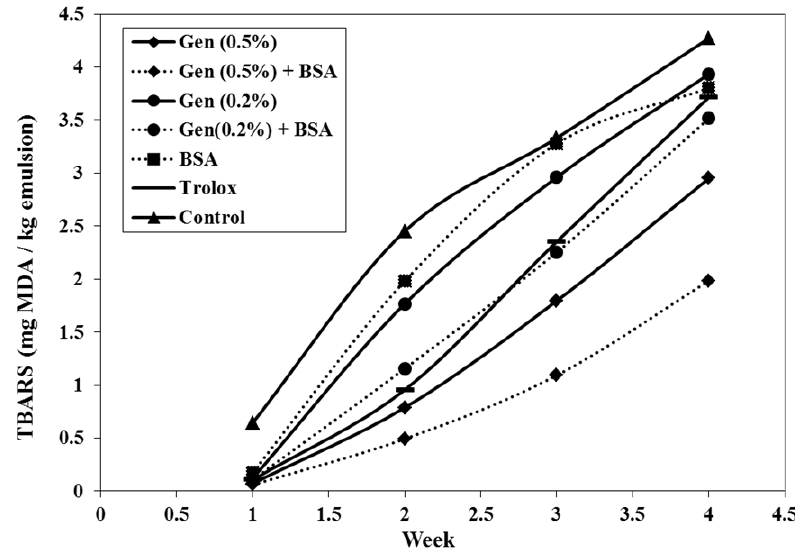
Figure 3. Change of Thiobarbituric Acid Reactive Substances (TBARS) over time, stored at 37 °C (each value is expressed as mean ( n =